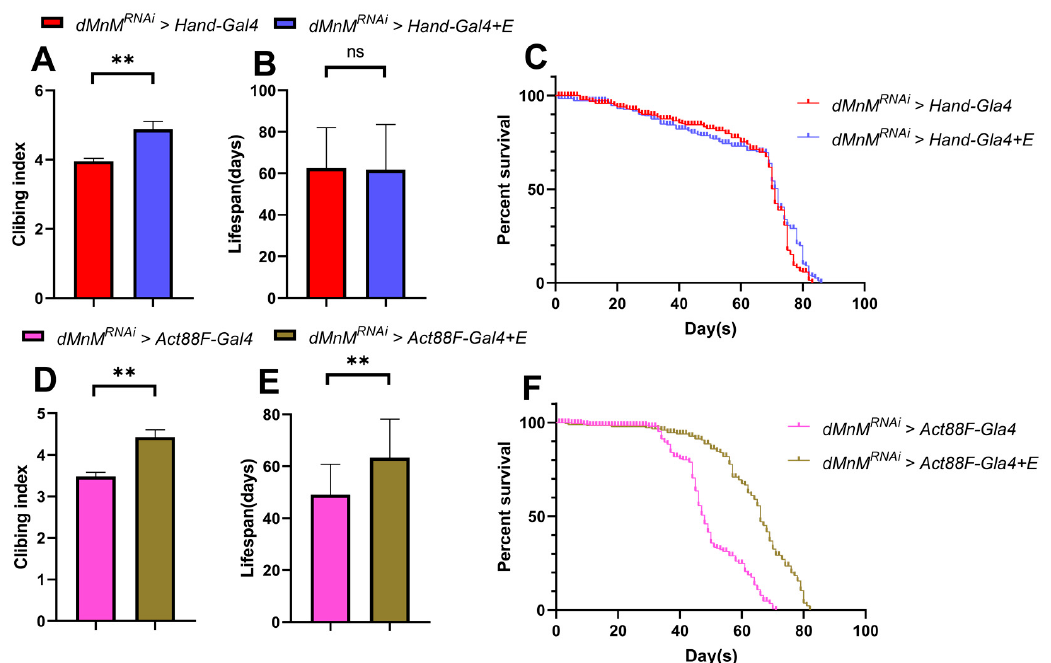
Figure 8. Effects of regular exercise on climbing and lifespan of Drosophila melanogaster after dMnM knockdown in cardiac myocytes and IFM. ( A ) Climbing results for the dMnM RNAi > Hand-Gal4 group. ( B , C ) Lifespan and survival curves for the dMnM RNAi > Hand-Gal4 group and dMnM RNAi > Hand-Gal4 + E group, respectively. ( D ) Climbing results for the dMnM RNAi > Act88F-Gal4 and dMnM RNAi > Act88F-Gal4 + E group. ( E , F ) Lifespan and survival curves of the dMnM RNAi > Hand-Gal4 and dMnM RNAi > Act88F-Gal4 + E groups, respectively, Climbing sample n = 100; lifespan sample n = 200. An independent-samples t -test was used to assess the difference between the two groups, ** p < 0.01, ns is not statistically significant.